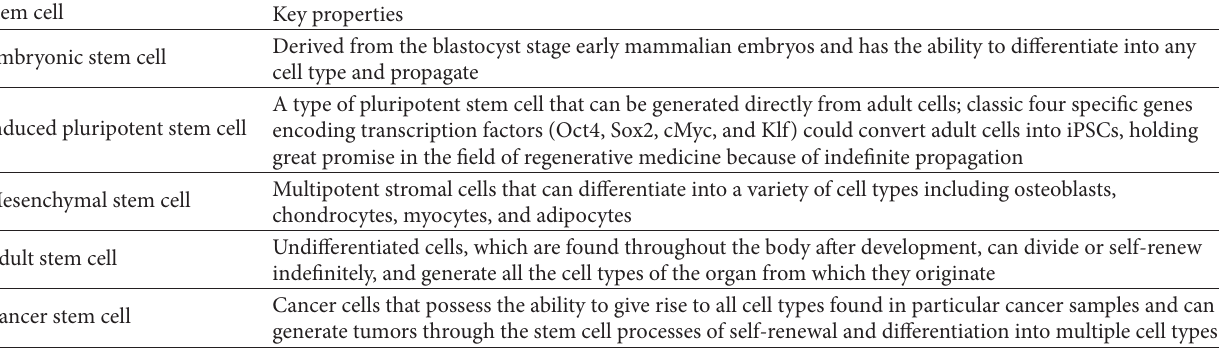
Table 1: Key properties of each stem cell